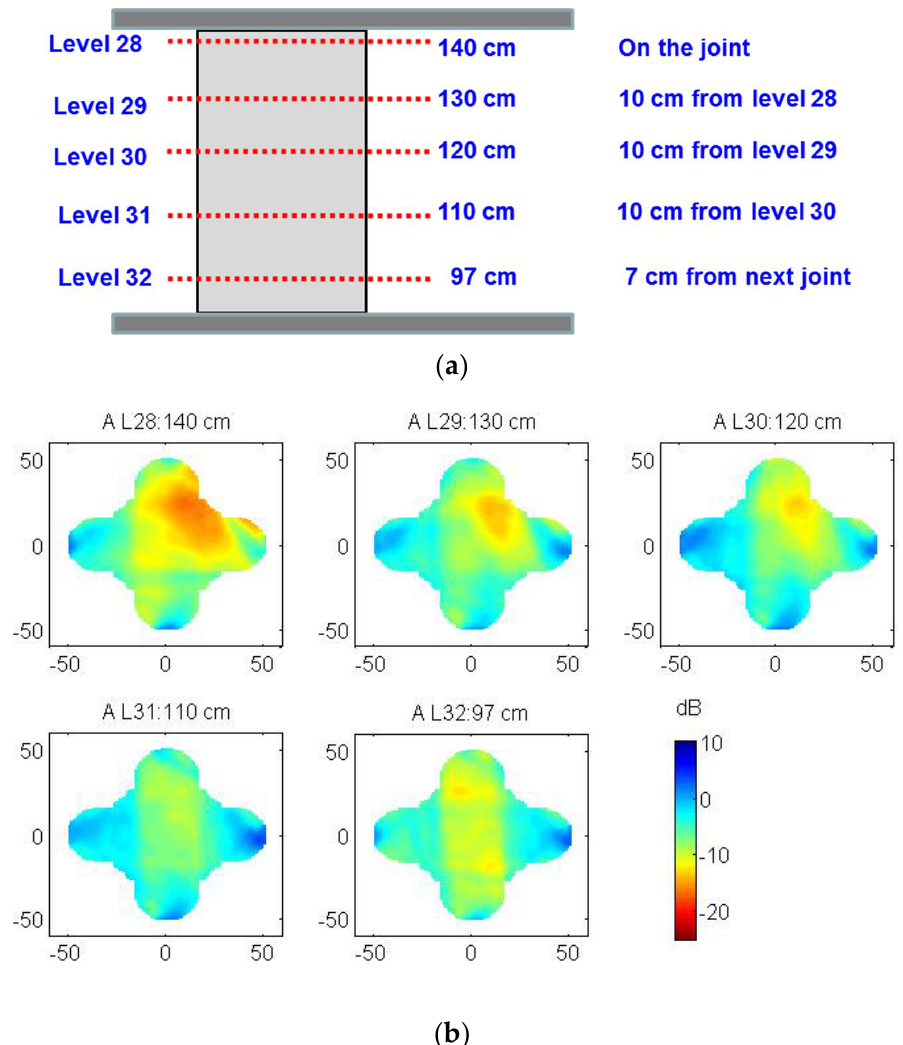
Figure 22. Tomographic images of drum 3 from column 3: ( a ) vertical section of the drum marking the location of the slices; ( b ) tomographic images of the slices.